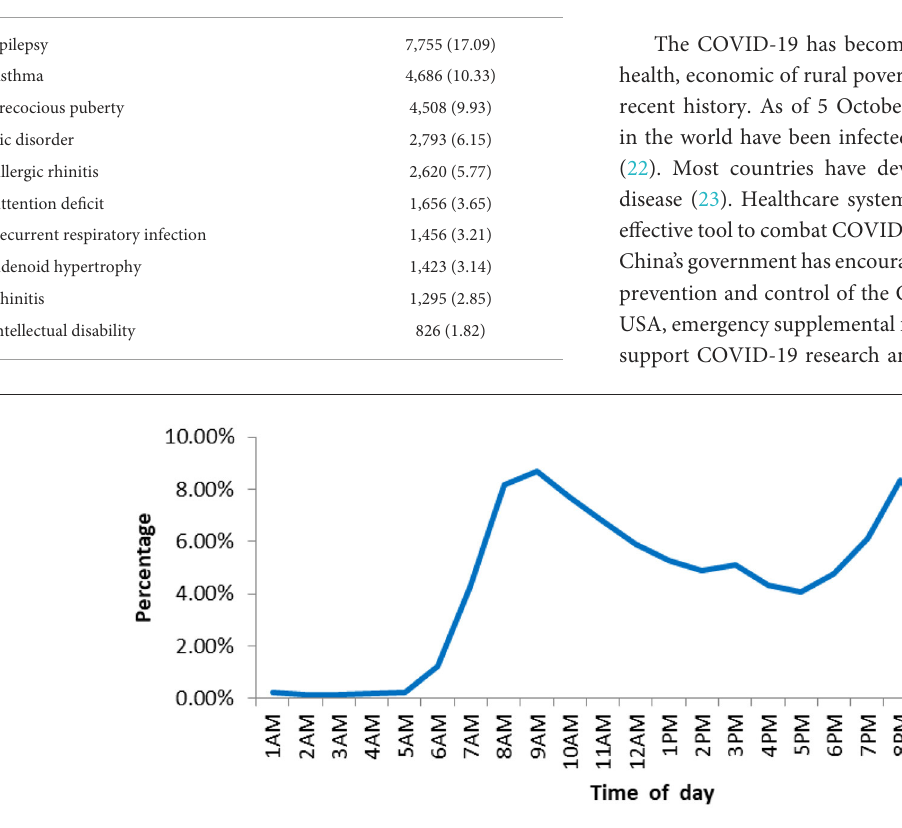
FIGURE5 Distribution of times of day for online